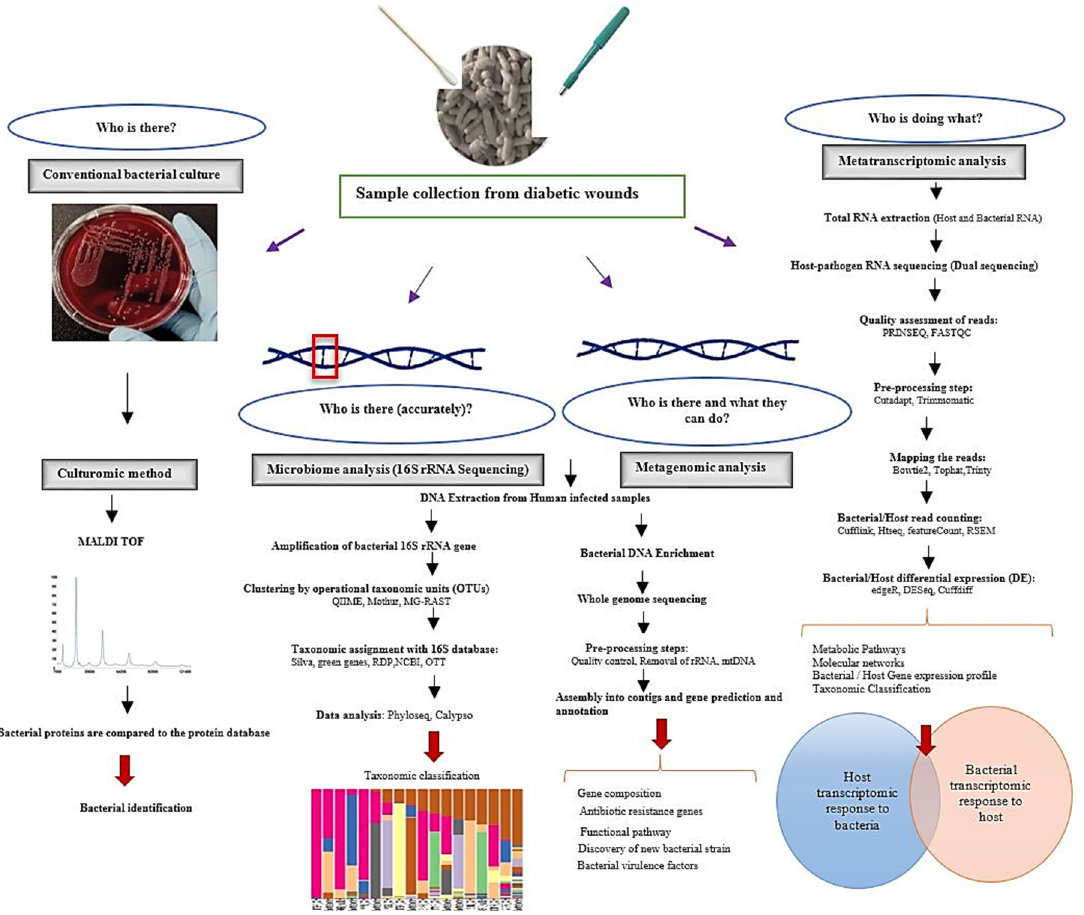
Figure 4. Overview of di ff erent approaches to evaluate bacterial species in infected cells.